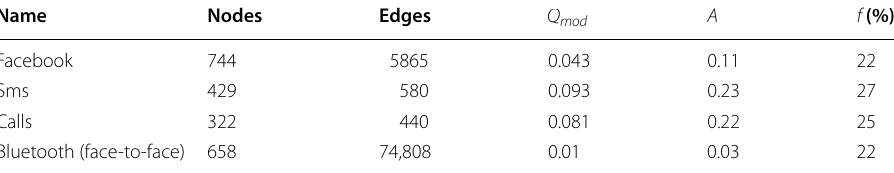
Table 3 Overview of Copenhagen Network Study networks (Sapiezynski et al. 2019)